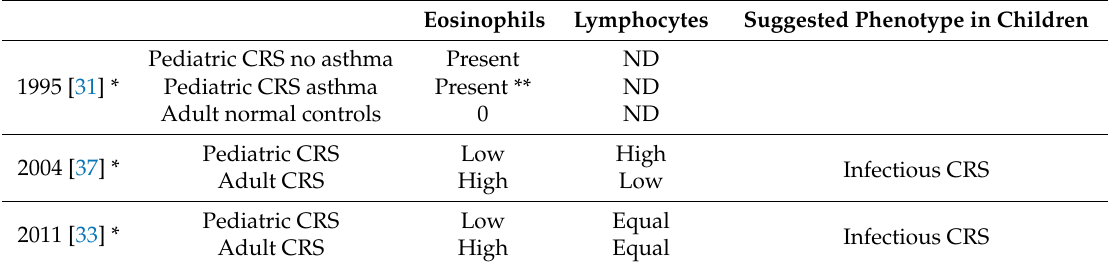
Table 1. Comparison of published histological studies of chronic rhinosinusitis (CRS) in children. Eosinophils Lymphocytes Suggested Phenotype in